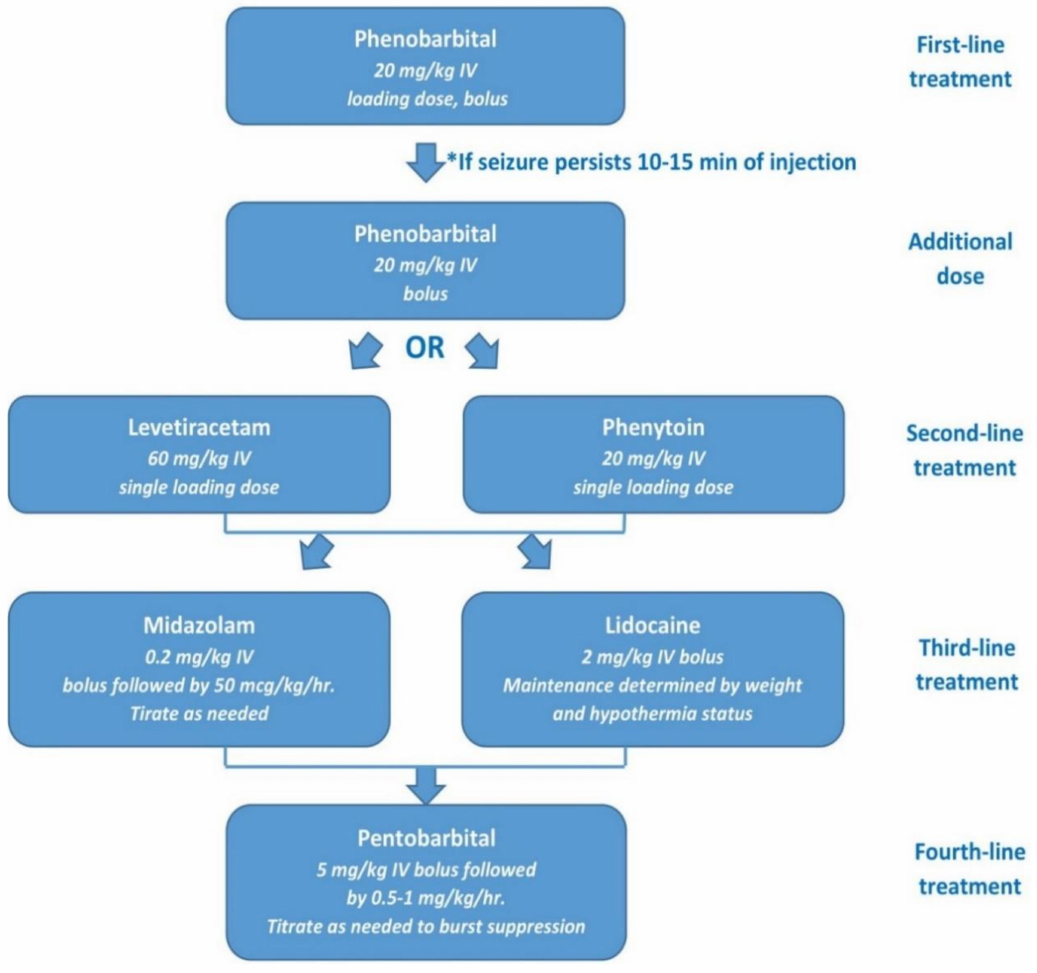
Figure 2. Sample algorithm for the pharmacotherapy of neonatal seizures